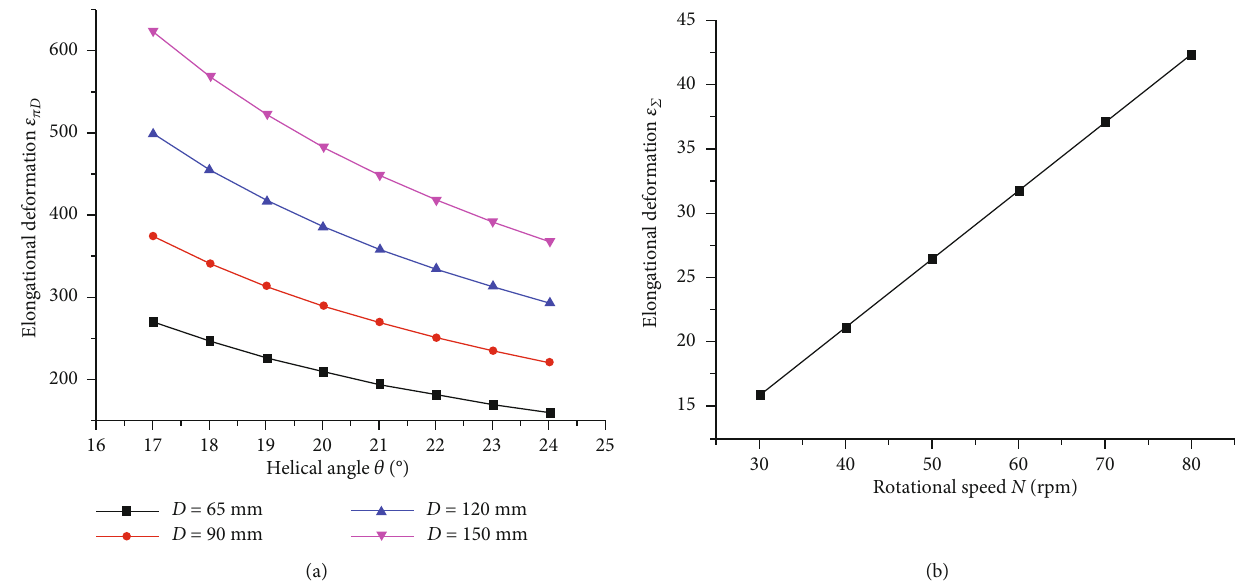
Figure 11: Numerical simulation of key factors a ff ecting elongational